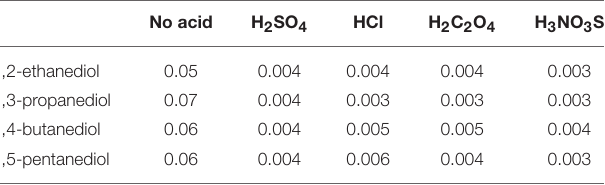
FIGURE 6 | (A) Illustration of promoting phosphoric acid to a mixture of glycerol and acid. (B) Schematic of the possible lubrication model between the two friction surfaces. The red and white spheres represent oxygen and hydrogen atoms, respectively. Li et al. (2013c) Copyright 2013, American Chemical Society. TABLE 1 | Lowest COF under lubrication with four kinds of polyhydroxy alcohols and their mixtures with four kinds of acid lubricants (H 2 SO 4 , HCl, H 2 C 2 O 4 , and H 3 NO 3 S, pH =